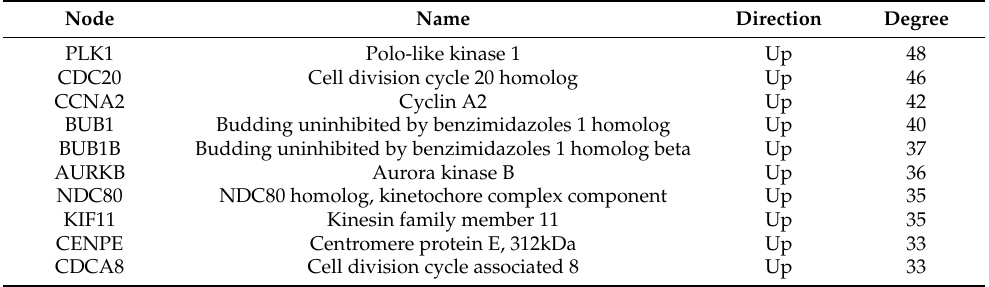
Table 3. Top 10 perturbed hub genes identified by protein-protein interaction network. Node Name Direction Degree